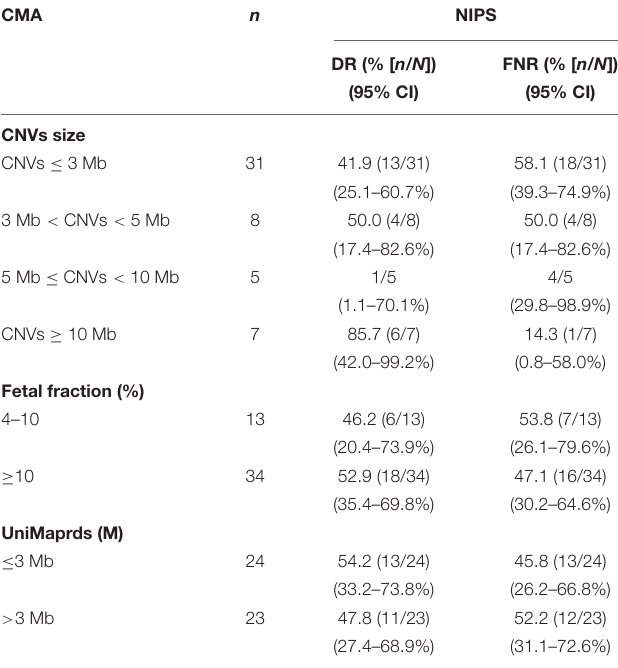
TABLE 4 | Factors influencing NIPS detection